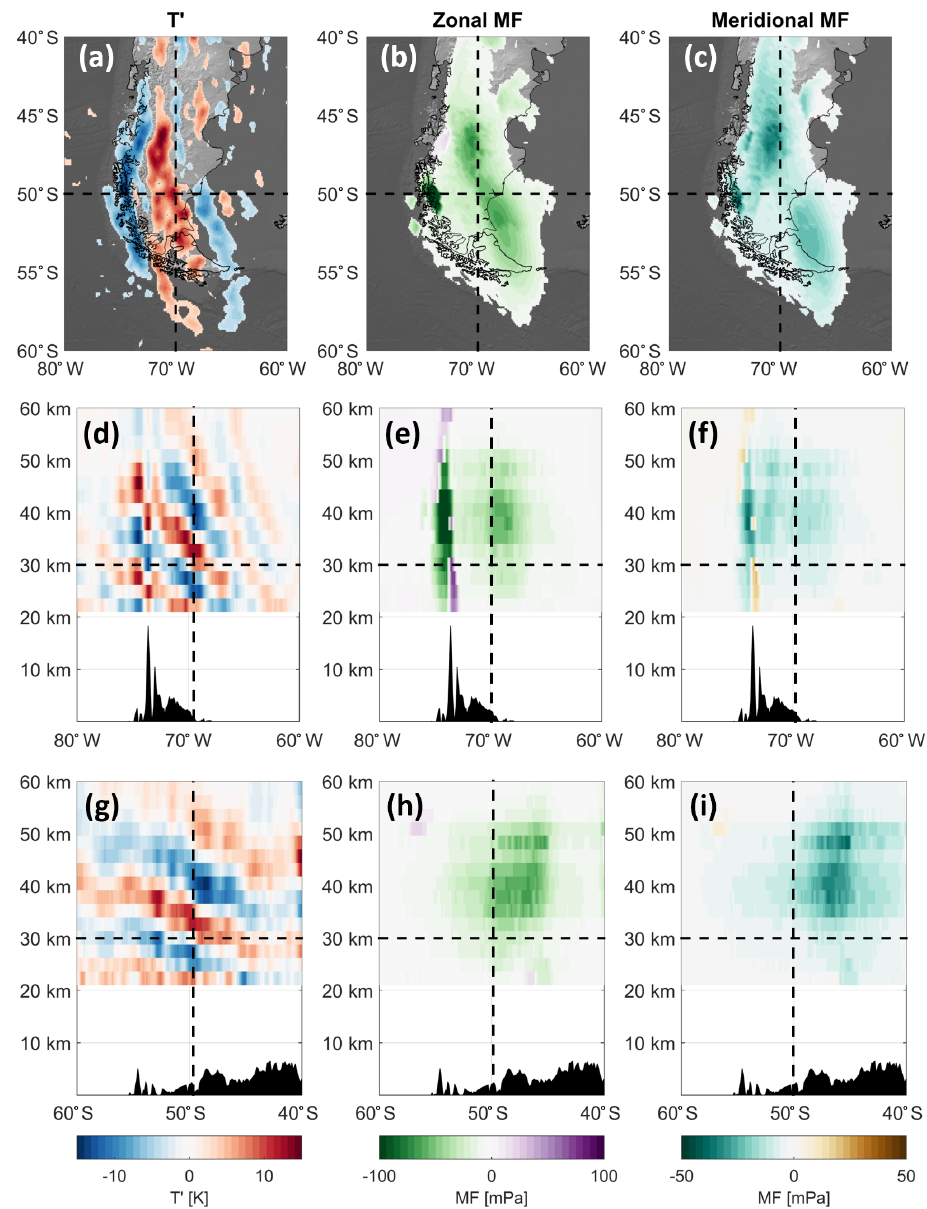
Figure 5. (a, d, g) T (cid:48) , (b, e, h) zonal MF and (c, f, i) meridional MF associated with the waves shown in Fig. 2. Panels (a–c) show maps at 30km altitude. (d–f) show data at 50 ◦ S, and (g–i) 70 ◦ W, both against height. Black shading in panels (d–i) shows surface topography, scaled by 5 for clarity. As in previous figures, the exponential increase in wave amplitude with altitude has been removed in (a, d, g) in order to highlight the vertical